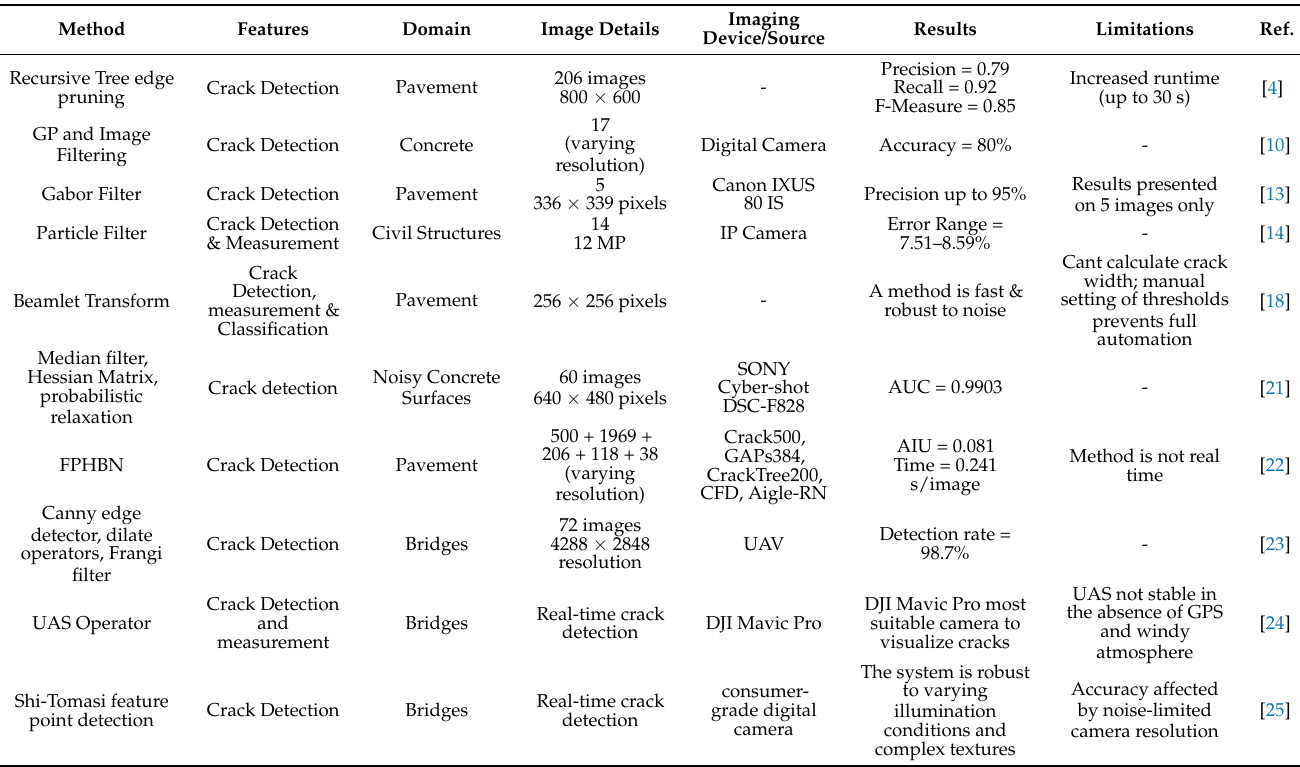
Table 1. Image Processing Methods for Crack